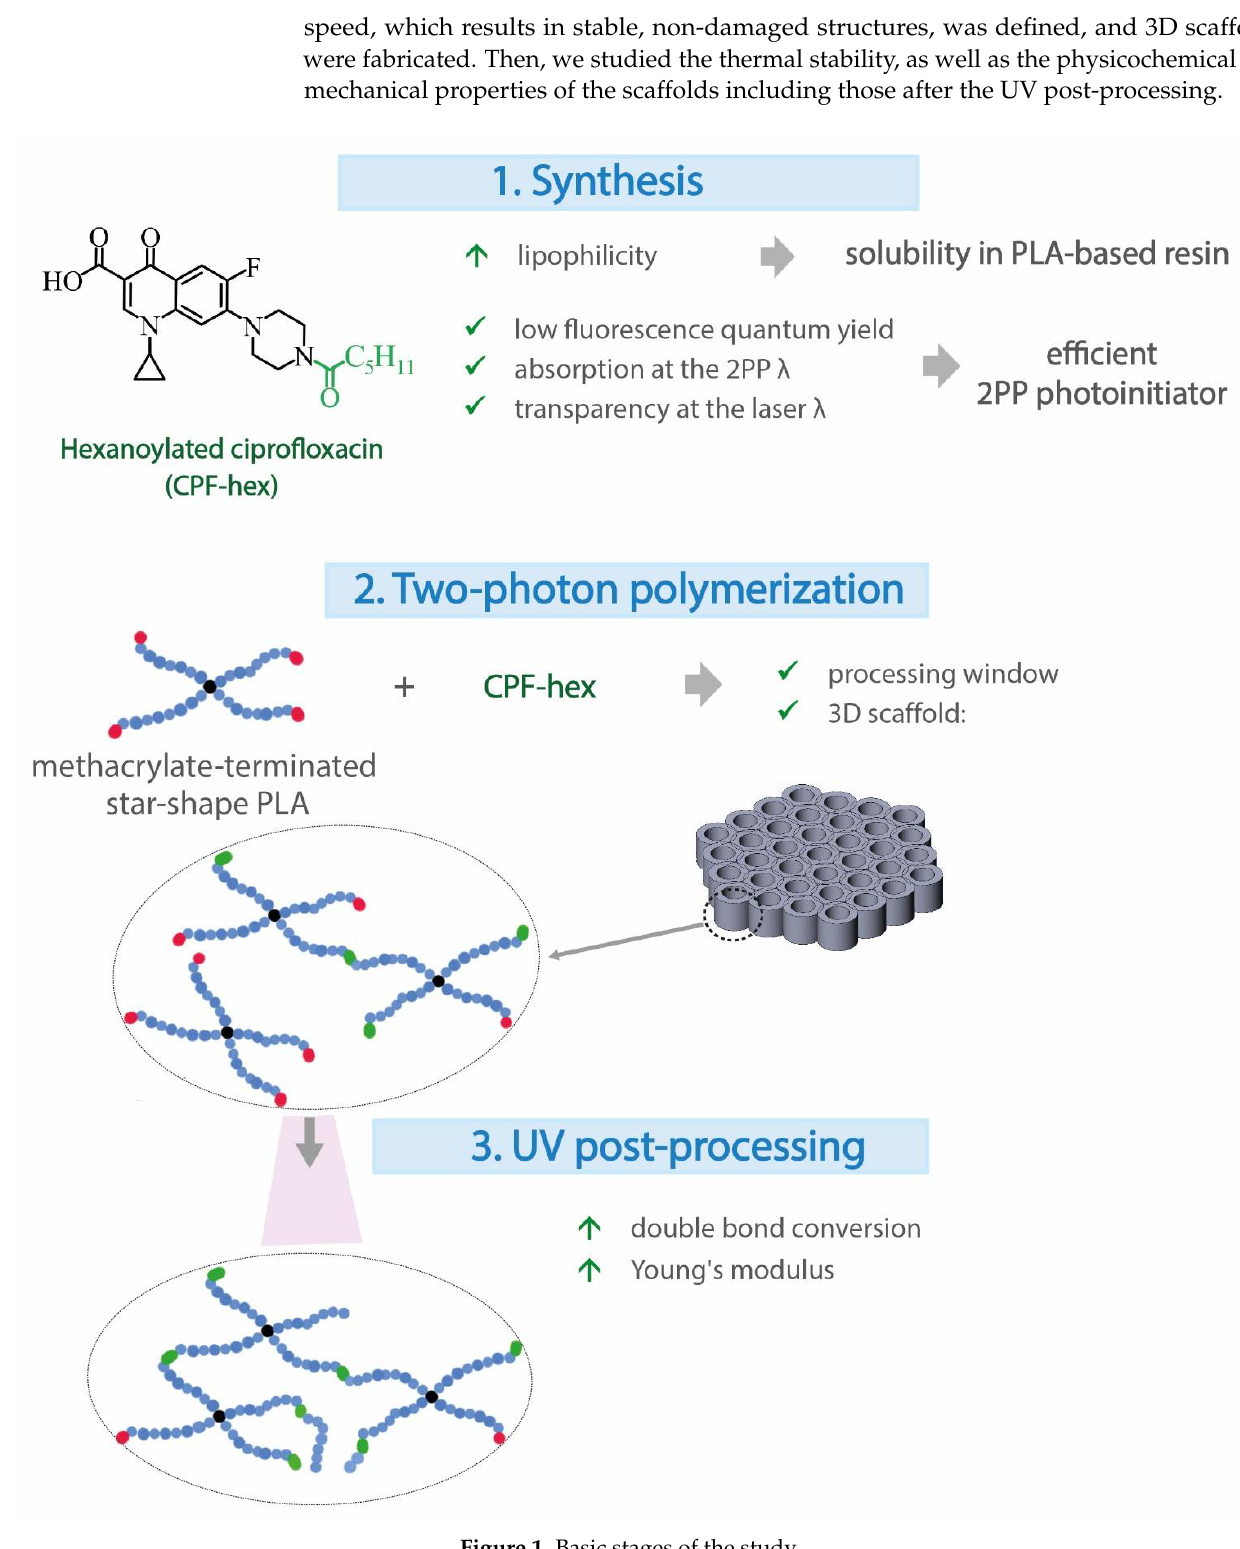
Figure 1. Basic stages of the study.